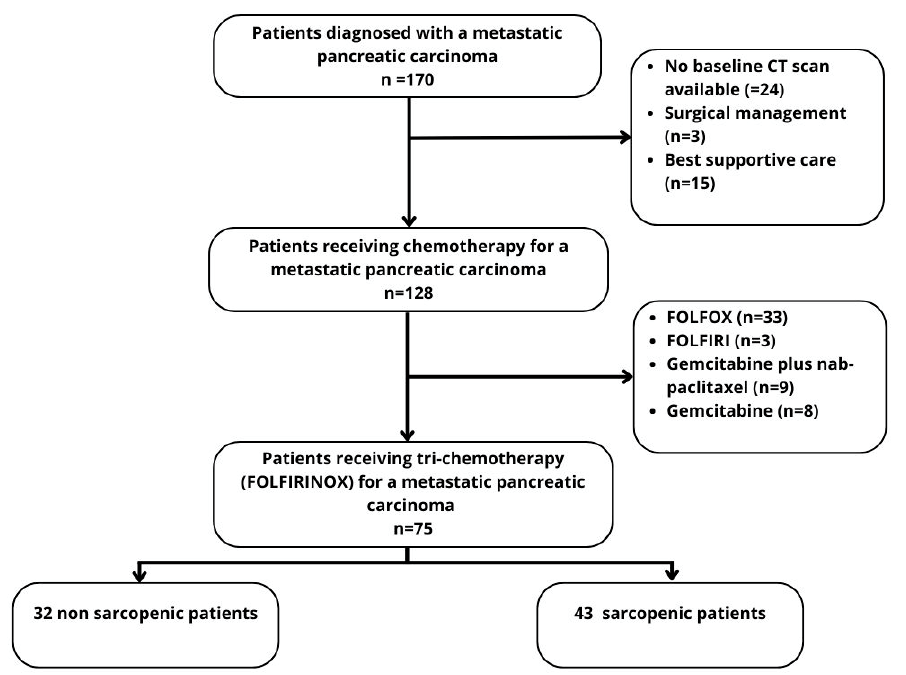
Figure 2. Flow-chart. Table 1. Patients’ characteristics at